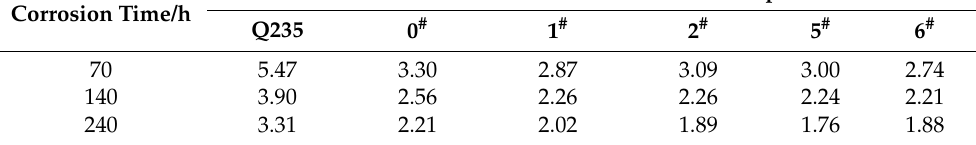
Table 1. Corrosion rate variation of steel with corrosion time [45]. Q235: 0.0 wt.% RE; 0.0 wt.% Cu.